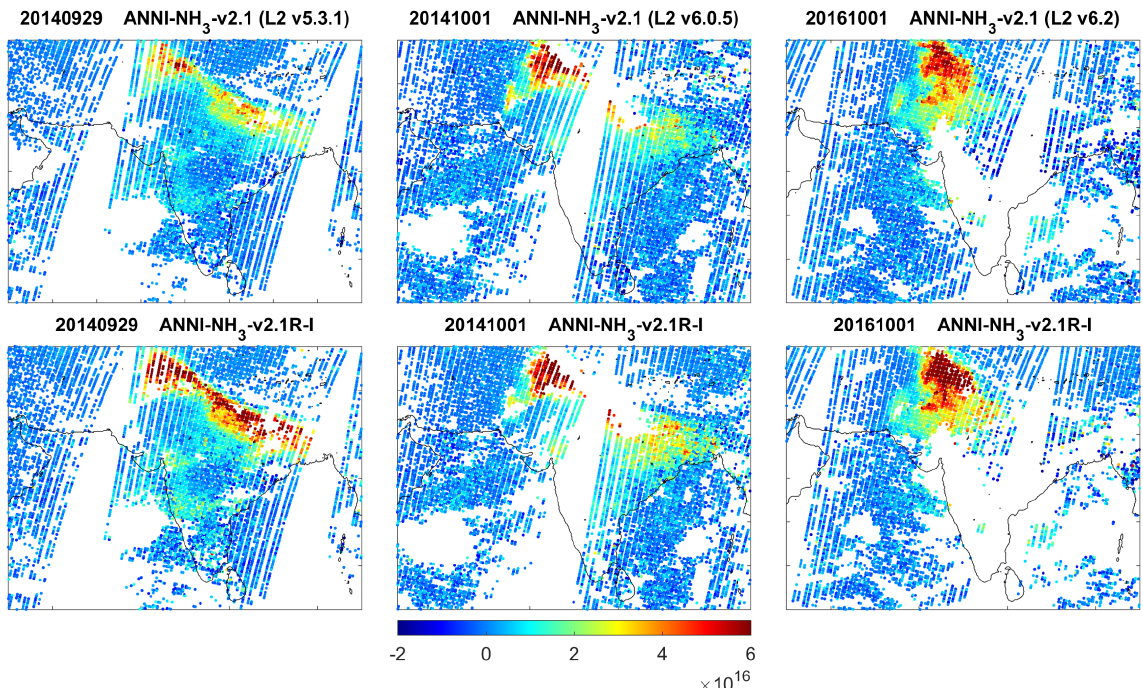
Figure 4. Example retrievals of the morning NH 3 column (moleccm − 2 ) over south Asia for the reanalysed retrieval (ANNI-NH 3 -v2.1R- I, bottom row) vs. the standard near-real-time retrieval (ANNI-NH 3 -v2.1, top row) on 29 September 2014 (input data from Eumetsat L2 v5.3.1), 1 October 2014 (L2 v6.0) and 1 October 2016 (L2 v6.2).